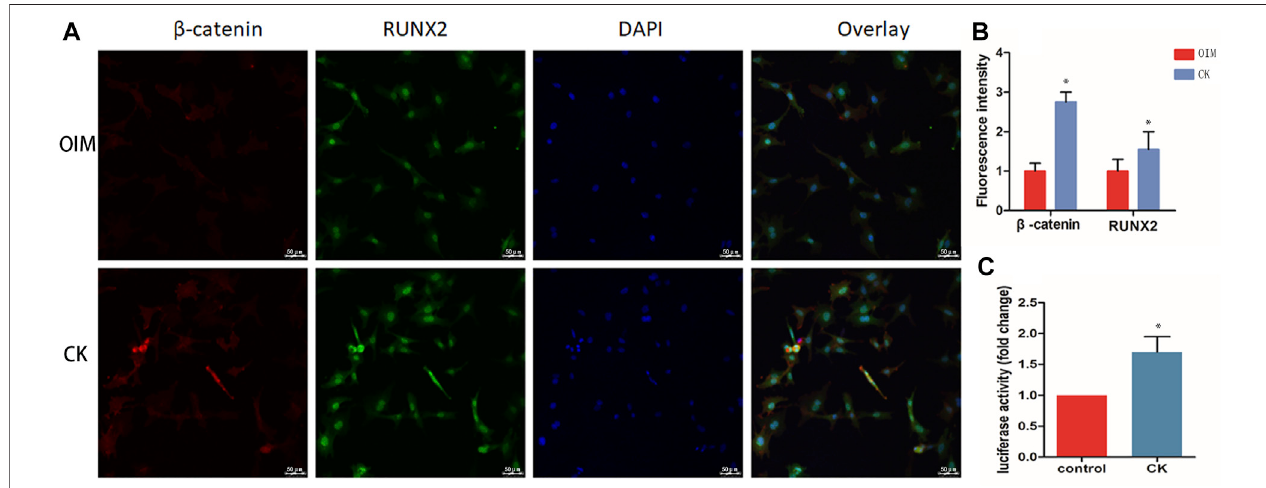
FIGURE 2 | CK increased β -catenin and Runx2 expression in BMSCs. (A) Representative images and (B) Quanti fi cation of immuno fl uorescence staining of β - catenin and Runx2 treated with 10 μ M CK for 24 h. Scale bars = 50 μ m, * p < 0.05, compared with the OIM group, n = 3 (C) The TOP fl ash luciferase activity was